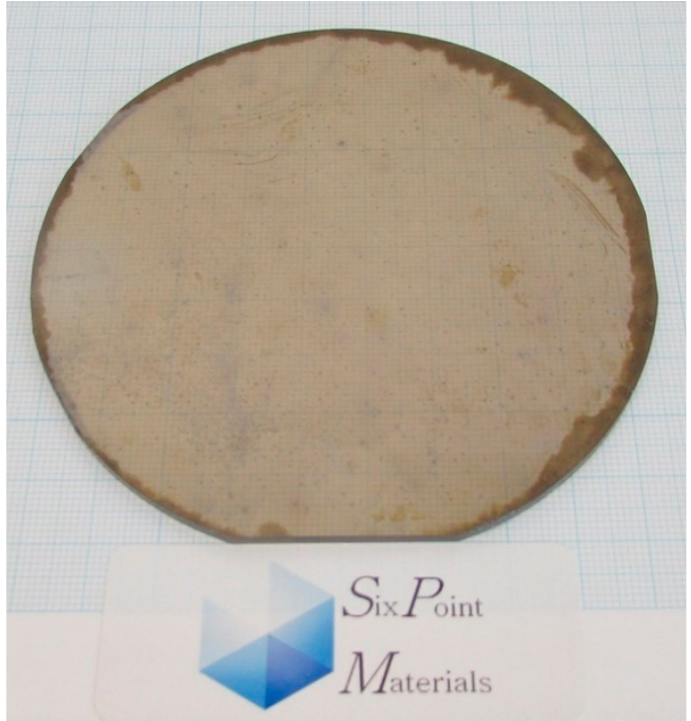
Figure 7. A photograph of 100 mm-diameter bulk GaN crystals grown by the NEAT method.